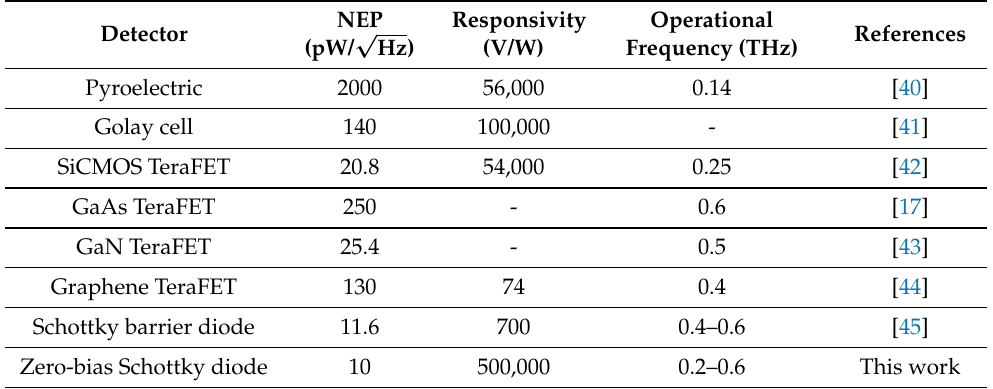
Table 1. Comparison of room temperature broadband THz detectors at their best operational values. Detector